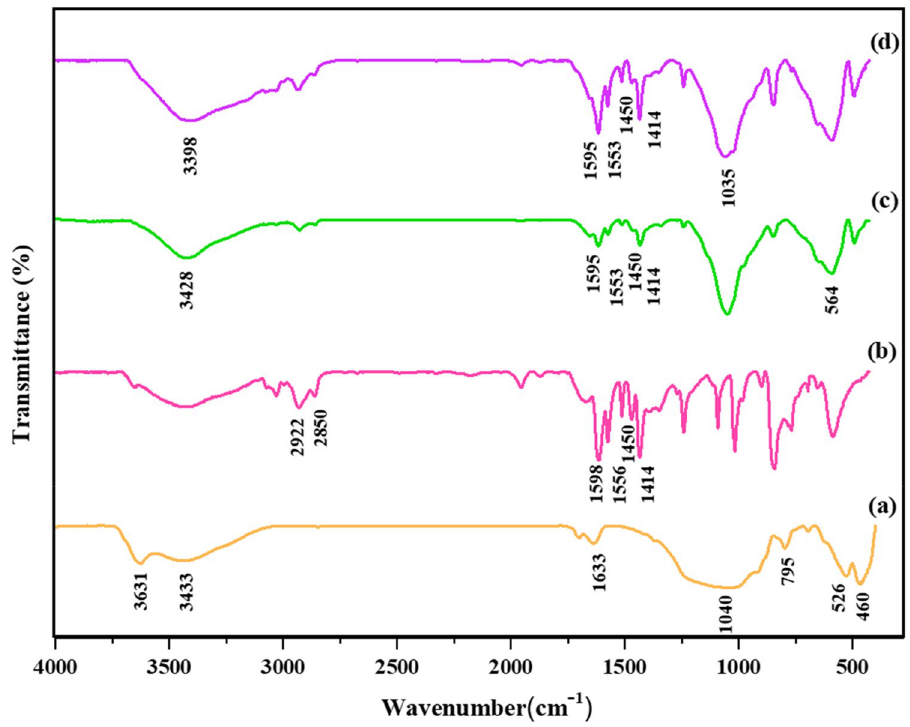
Figure 4. Normalized FT-IR spectra of ( a ) bentonite, ( b ) PVP-DVB, ( c ) Fe-Ben/ PVP-DVB , and ( d ) Fe-Ben/ PVP-DVB/Pd